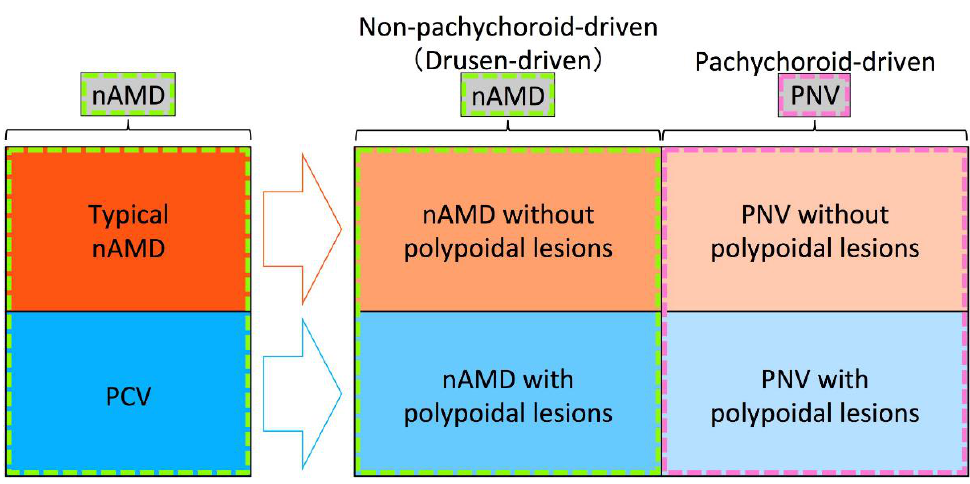
Figure 2. Recommended framework for future studies on pachychoroid diseases. Among exudative maculopathy previously diagnosed as neovascular age-related macular degeneration (nAMD), typical nAMD is divided into nAMD without polypoidal lesions and pachychoroid neovasculopathy (PNV) without polypoidal lesions, and polypoidal choroidal vasculopathy (PCV) is divided into nAMD with polypoidal lesions and PNV with polypoidal lesions, after the development of the pachychoroid concept. In the era of the pachychoroid concept, nAMD includes non-pachychoroid-driven (drusen-driven) nAMD with and without polypoidal lesions, and PNV includes PNV with and without polypoidal lesions.